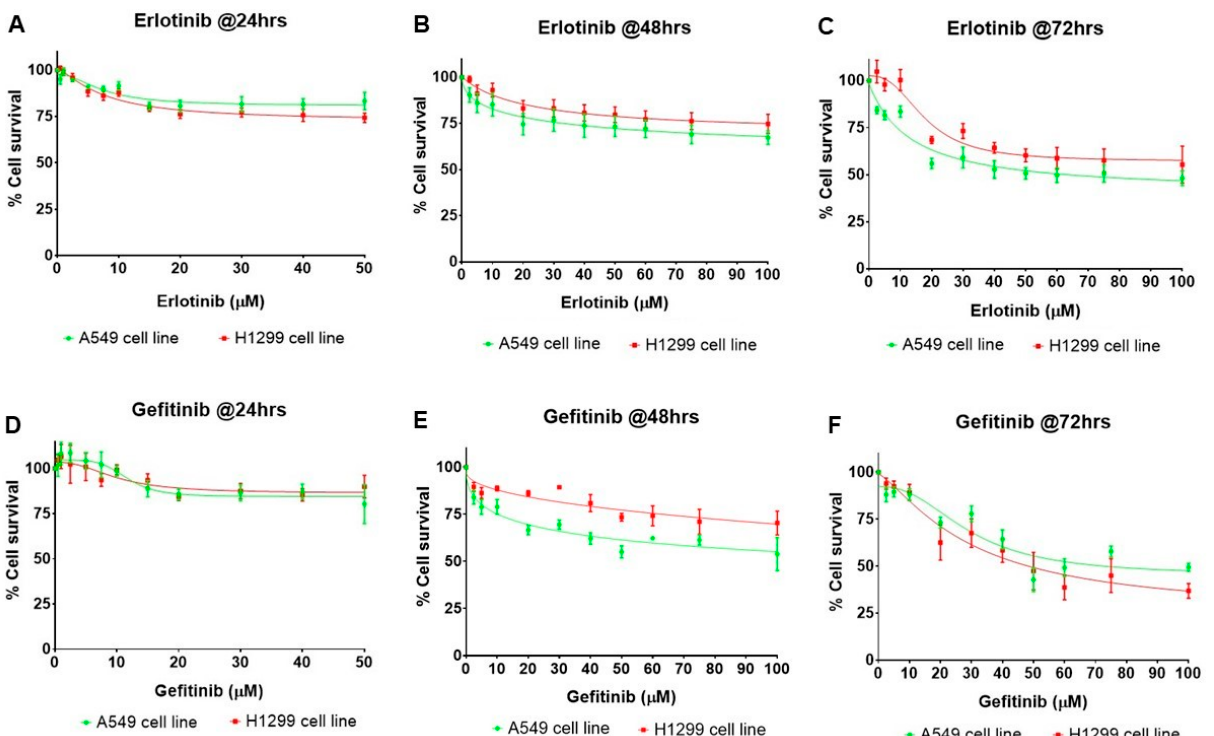
Figure 5. Effects of erlotinib and gefitinib on the survival of human NSCLC cells. ( A – F ) A549 and H1299 cells were treated with vehicle (0.1% DMSO) or various concentrations of erlotinib or gefitinib, and incubated for 24, 48, and 72 h. The cell survival was measured via the sulforhodamine B (SRB) assay. Data are expressed as the mean ± SE of three independent experiments and are presented as the percentage (%) of cell survival against erlotinib or gefitinib treatments.